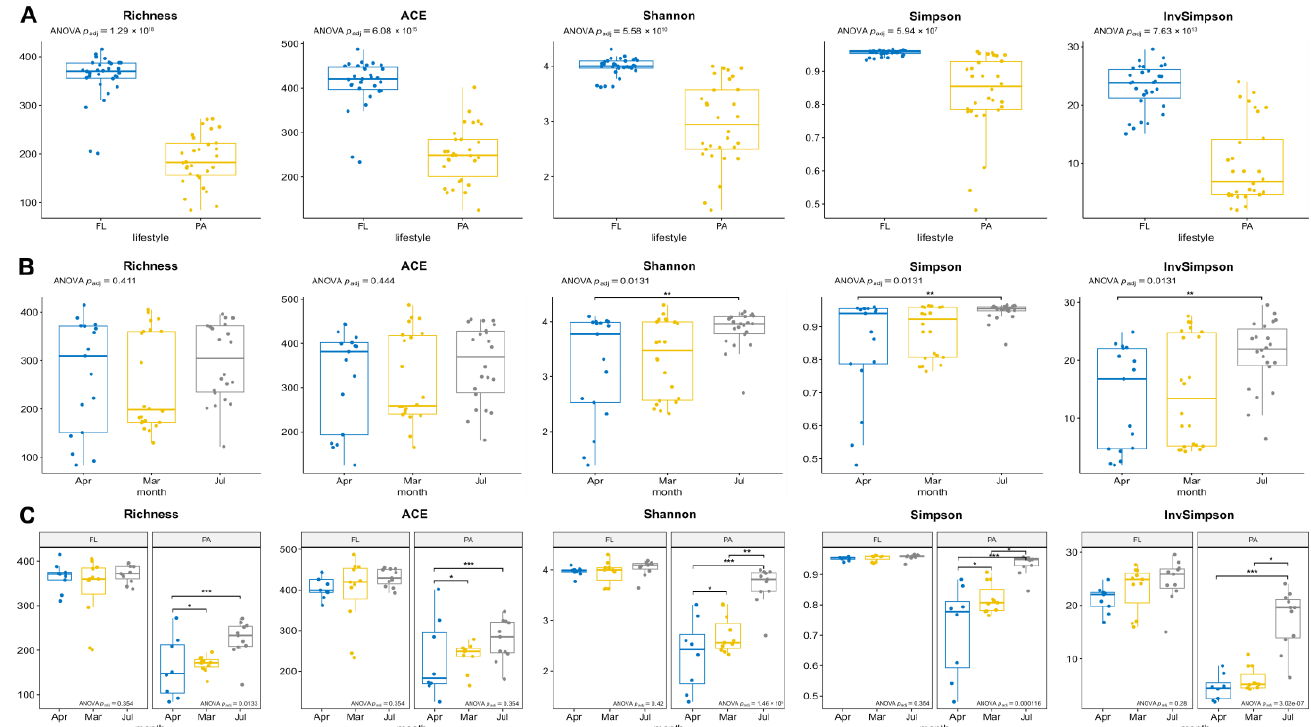
Figure 6. Alpha richness and diversity indices in bacterial communities. Comparison of FL and PA communities ( A ); communities of different seasons ( B ); FL and PA communities in different seasons ( C ). Significance code of Tukey’s post hoc tests: *** ≤ 0.001; 0.001 ≤ ** ≤ 0.01; 0.01 ≤ * ≤ 0.05.